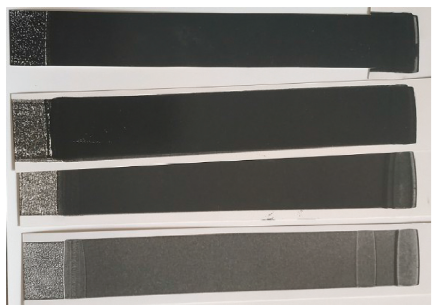
Figure 1: Examples of printing strips.